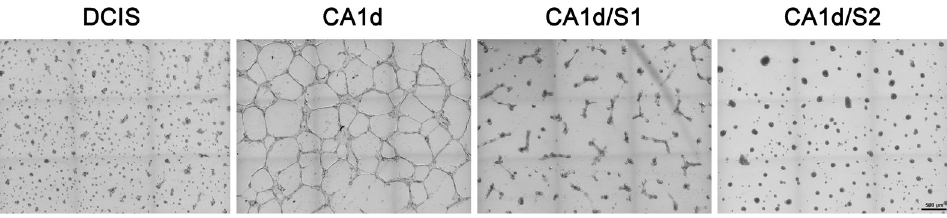
Fig 7. Sprouty4 overexpression induces phenotypic reversion of MCF10.CA1d cells. MCF10.DCIS, MCF10.CA1d control and Sprouty4 overexpressing cell lines (MCF10.CA1d/S1 and MCF10.CA1d/S2) were grown in 3D rBM overlay cultures. By 48 hours, structural differences were observed between the MCF10.CA1d and overexpression lines. Sprouty4 overexpressing cells exhibited phenotypic reversion and resembled the isogenic DCIS line more than the parental invasive line. Differential interference contrast images were captured on a Zeiss Cell Observer spinning disk confocal microscope using a 5x objective and stitching nine contiguous fields (3x3) together to ensure reproducibility; size bar = 500 μ m. Images are representative of three independent experiments.